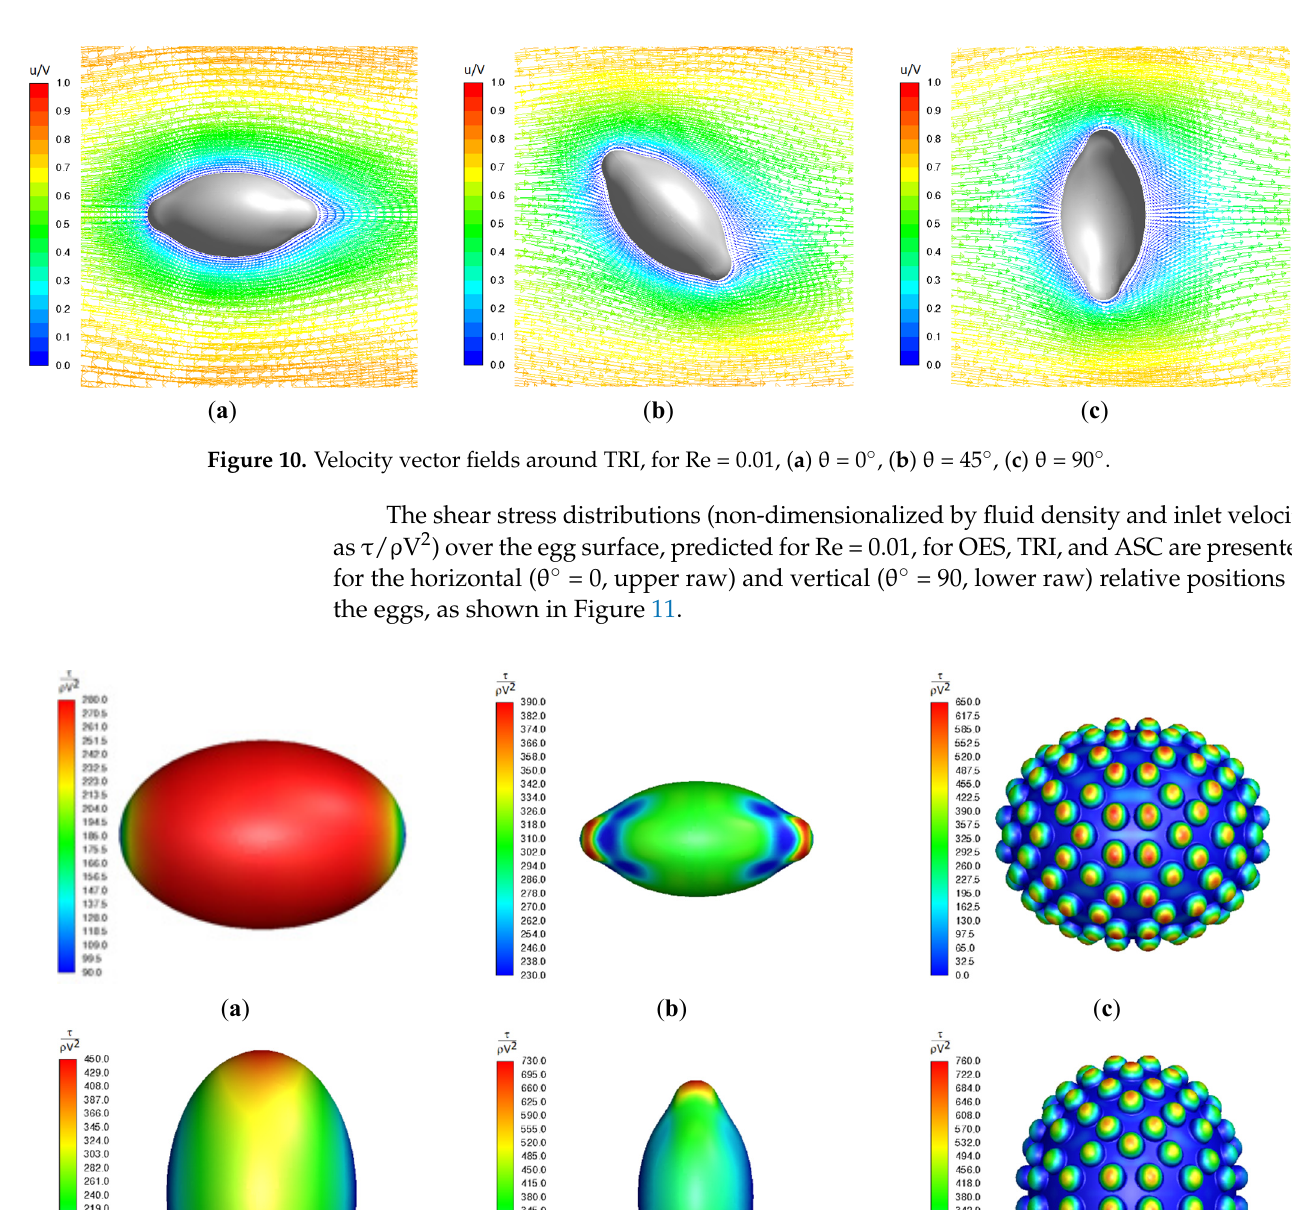
Figure 11. Dimensionless shear stress distribution over egg surface, for Re = 0.01, ( a ) OES, θ = 0°, ( b ) TRI, θ ° = 0, ( c ) ASC, θ = 0°, ( d ) OES, θ = 90°, ( e ) TRI, θ ° = 90, ( f ) ASC, θ = 90°.